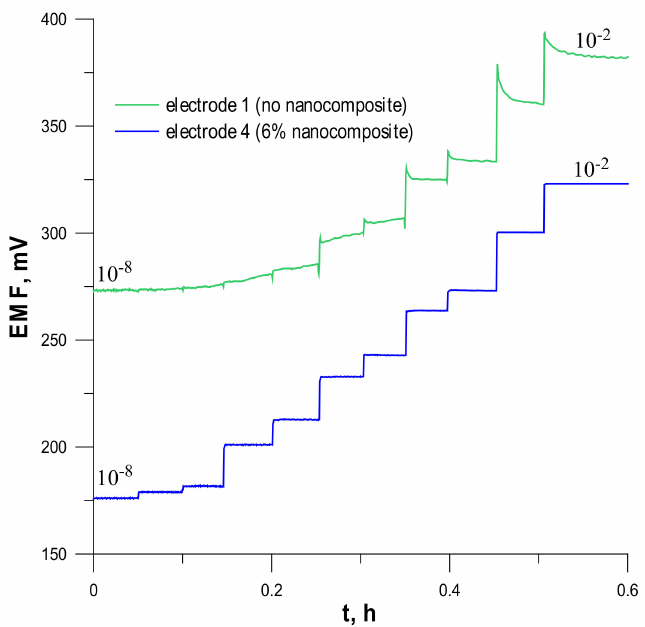
Figure 2. Potentiometric dynamic response for tested unmodified electrode 1 and electrode 4.